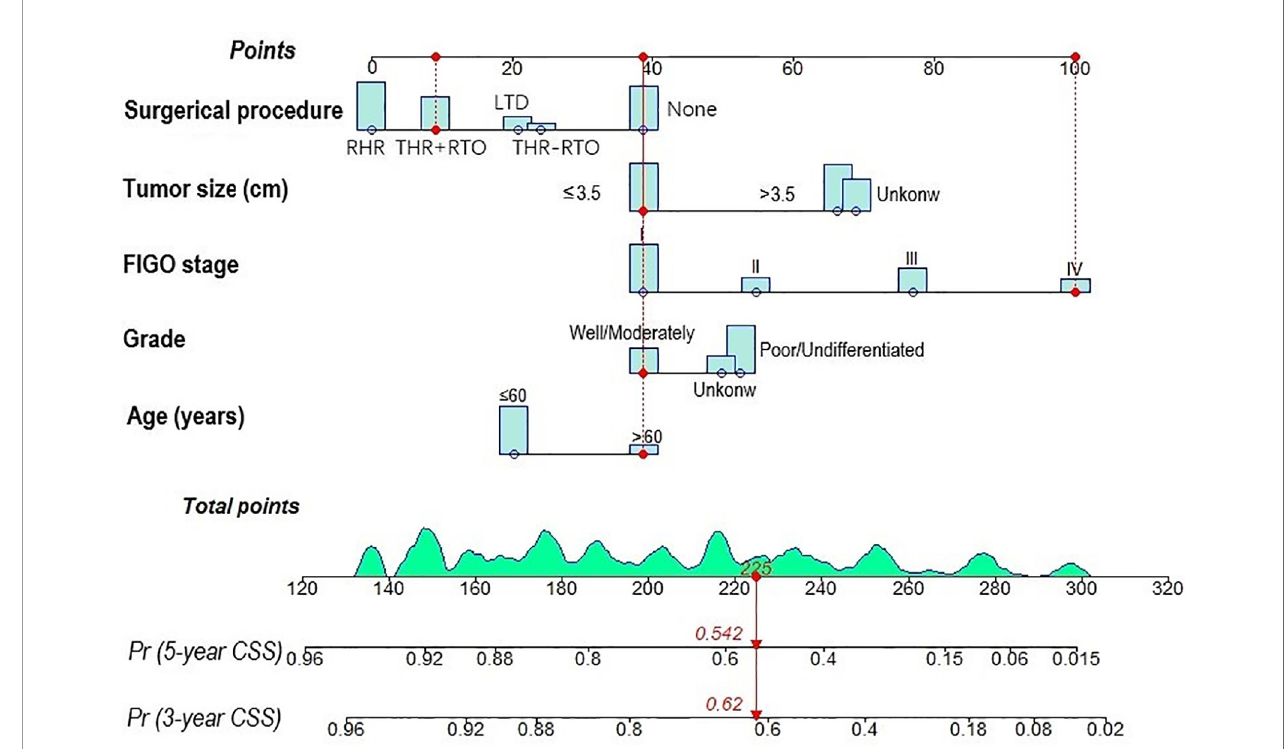
FIGURE 2 | Nomogram for predicting 3- and 5-year cancer-speci fi c survival of ASCC